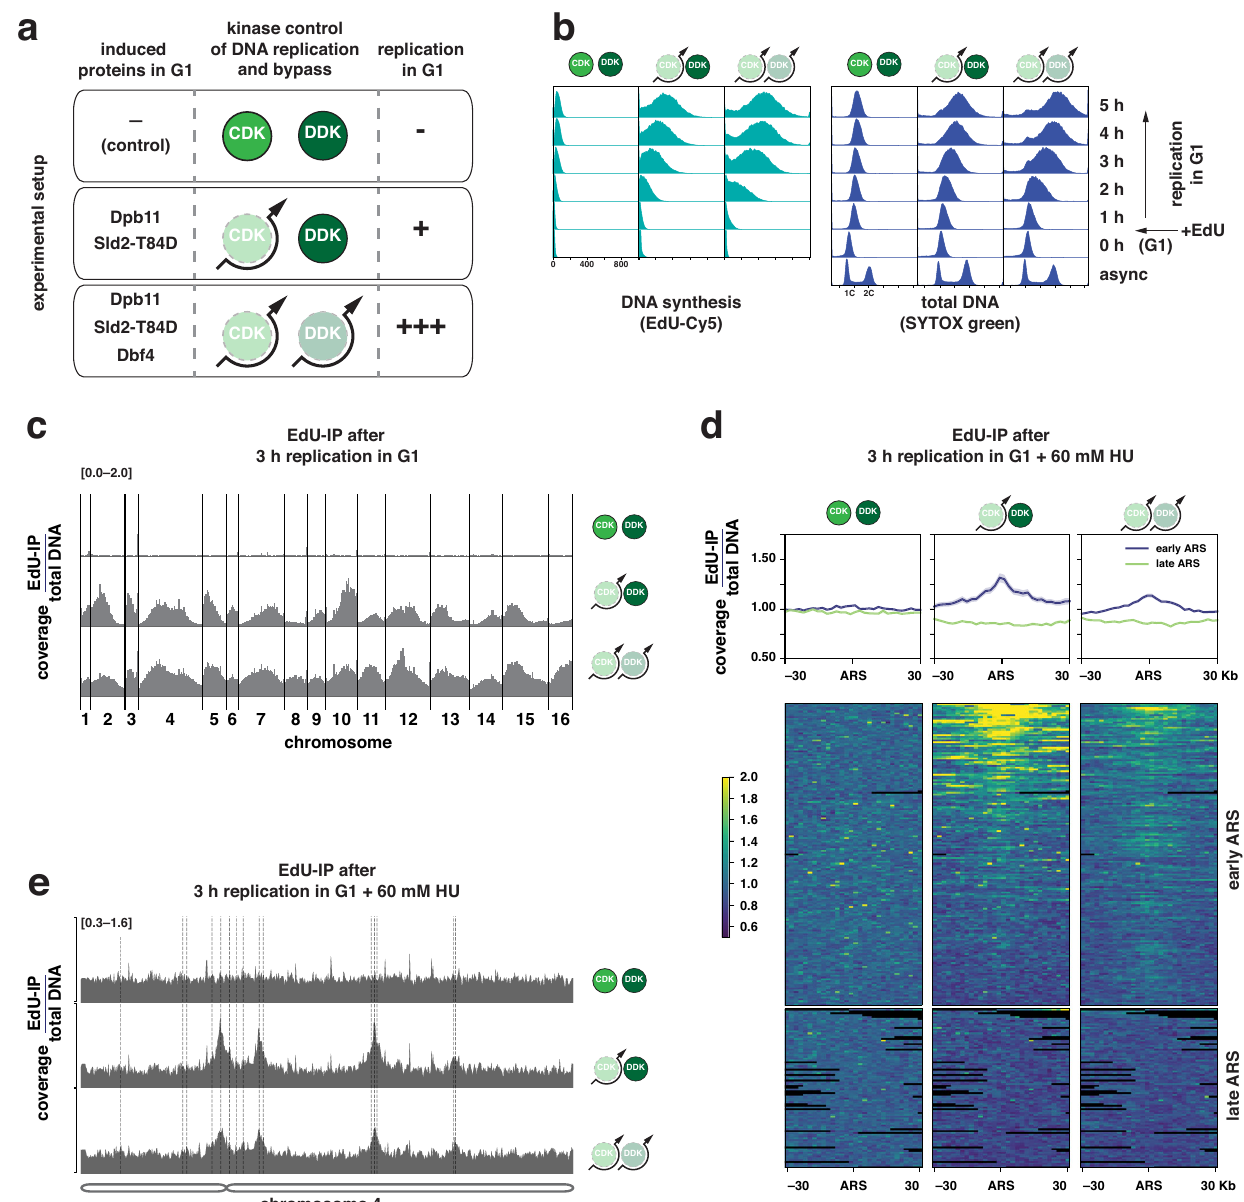
Fig. 1 | Unscheduled replication in G1 initiates at canonical replication origins genome-wide. a Summaryof engineered geneticchanges thatallowto bypass cell cycle control of DNA replication initiation and induce unscheduled replication in G1.Indicatedproteinsandvariantsareexpressedfromagalactose-inducible pGAL1- 10 promoter. Experimental setup for G1 replication involves G1 cell cycle arrest using α -factor in raf fi nose medium, followed by induction of G1 replication by additionofgalactose.ExpressionofDpb11andSld2-T84DallowsforbypassofCDK controls, additional expression of Dbf4 allows for bypass of DDK controls. Picto- gramsindicategeneticbypassinall fi gures. b BypassingCDKcontrolandCDK/DDK control generates different levels of unscheduled replication in G1. Cells were arrested in G1 and replication was induced by adding galactose. EdU (100 µ M) was added to the G1-arrested cells right after induction of replication. Cells were har- vestedatindicatedtimepointsafterreplicationinductionandEdU-containingDNA was labeled with Cy5. Total DNA content (stained by SYTOX green) and newly synthesized DNA (EdU-Cy5-labeled) were measured by fl ow cytometry. Data are representative of n =3 biological replicates. c Unscheduled replication in G1 after